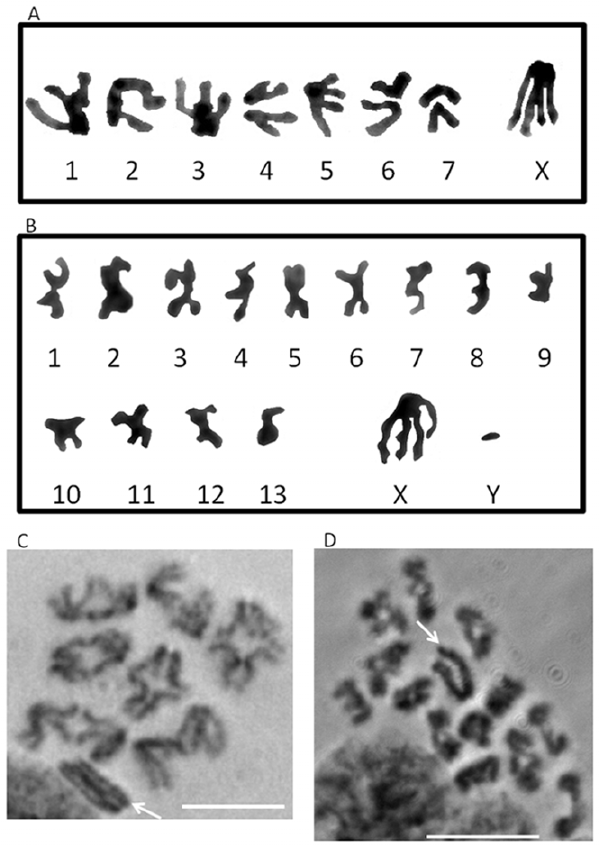
Figure 1. Karyotypes for Physocyclusmexicanus and Holocnemus pluchei and giemsa-stained meiosis I spermatocytes. A. Haploid karyotype for Physocyclus mexicanus taken from fixed, giemsa-stained metaphase II spermatocyte. B. Haploid karyotype for Holocnemus pluchei taken from a fixed, giemsa-stained metaphase II spermatocyte (chromosomes 1–13 and Y chromosome) and a fixed, giemsa-stained anaphase I spermatocyte (X chromosome). C. Giemsa-stained meta- phase I spermatocyte of Physocyclus mexicanus . X chromosome indicated by arrow. Bar=10 m m. D. Giemsa-stained metaphase I spermatocyte of Holocnemus pluchei . X-Y bivalent indicated by arrow. Bar=10 m m.